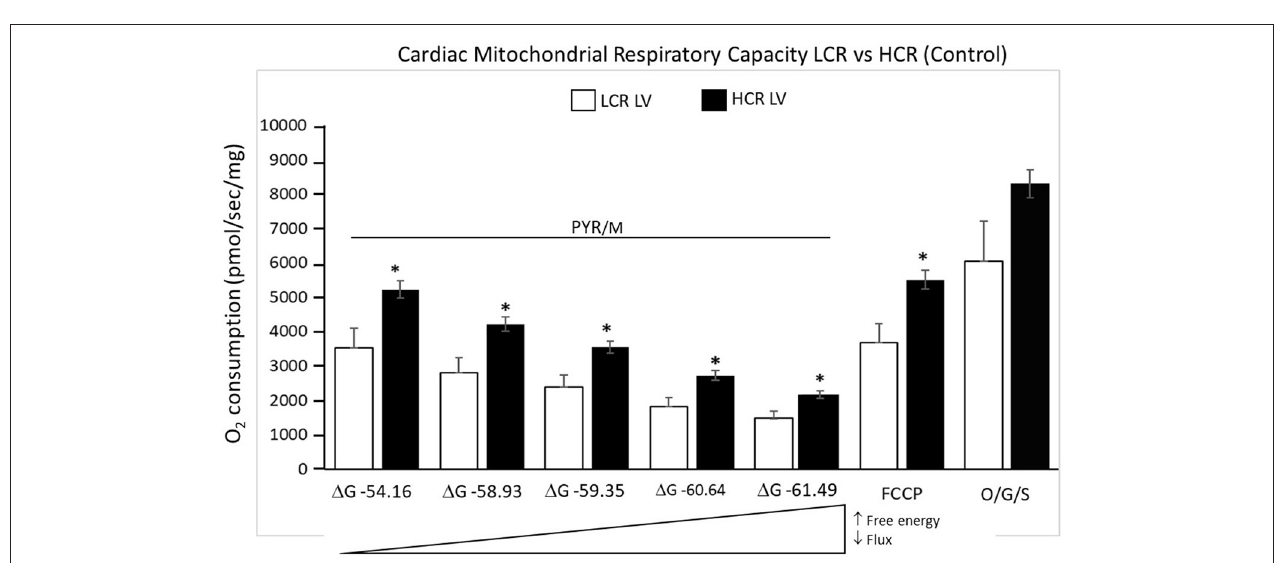
FIGURE 4 | Summary of mitochondrial respiration results in samples isolated from HCR and LCR control ventricles. The top inset shows representative tracing, while the graphic summarizes group results. Data are expressed as mean ± SD. n = 8 per group. * p < 0.05 in designated